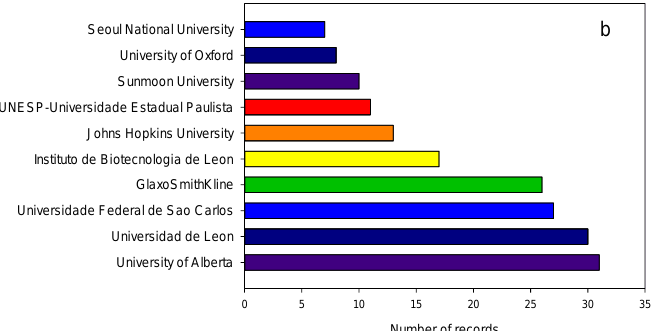
Figure 8. Summary of publications on clavulanic acid production by Streptomyces clavuligerus between 1976 and 2017. ( a ) Top 10 leading countries in the field of clavulanic acid production by Streptomyces clavuligerus . ( b ) Top 10 leading institutions in the field of clavulanic acid production by Streptomyces clavuligerus .